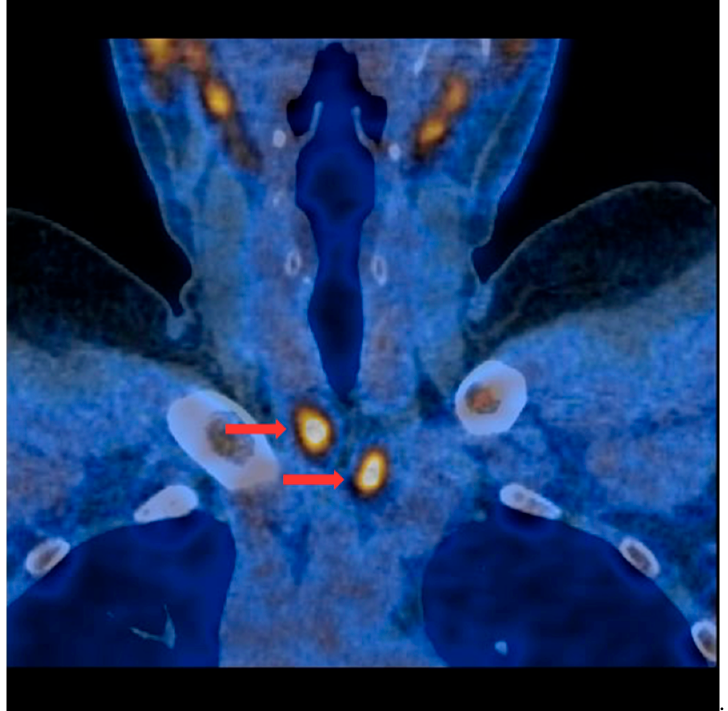
Figure 3. PET/CT with [ 11 C]MET—frontal projection. Two visible foci of increased radiotracer accumulation (red arrows) corresponding to the parathyroid glands (multiple lesions) below both thyroid